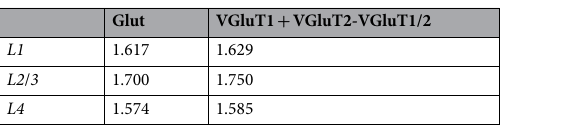
Table 3. Density distribution of excitatory synapses across layers as calculated by two methods. Units are number of synapses per cubic